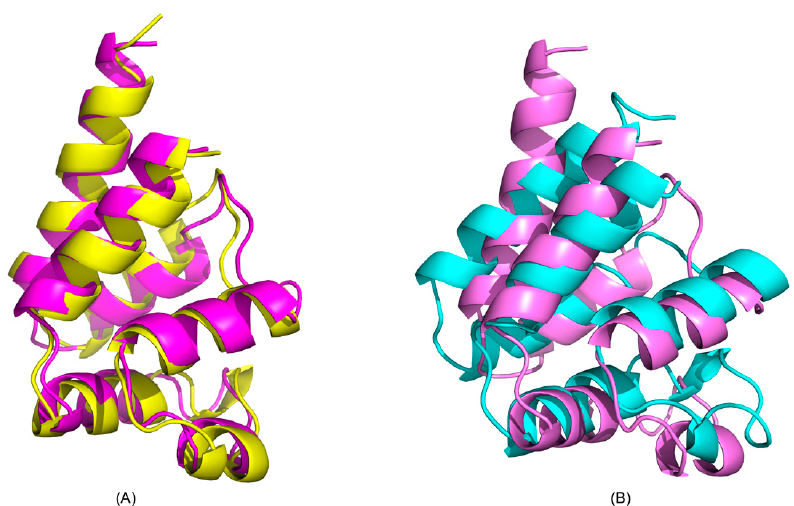
Figure 2. CS-Rosetta structural models superimposed with published structure of PEA-15 (Protein Data Bank (PDB) ID 2SL7). ( A ) Superimposition of the free-form structure (yellow) with 2LS7 (magenta). ( B ) Superimposition of the ERK2-bound form structure (cyan) with 2LS7 (magenta).